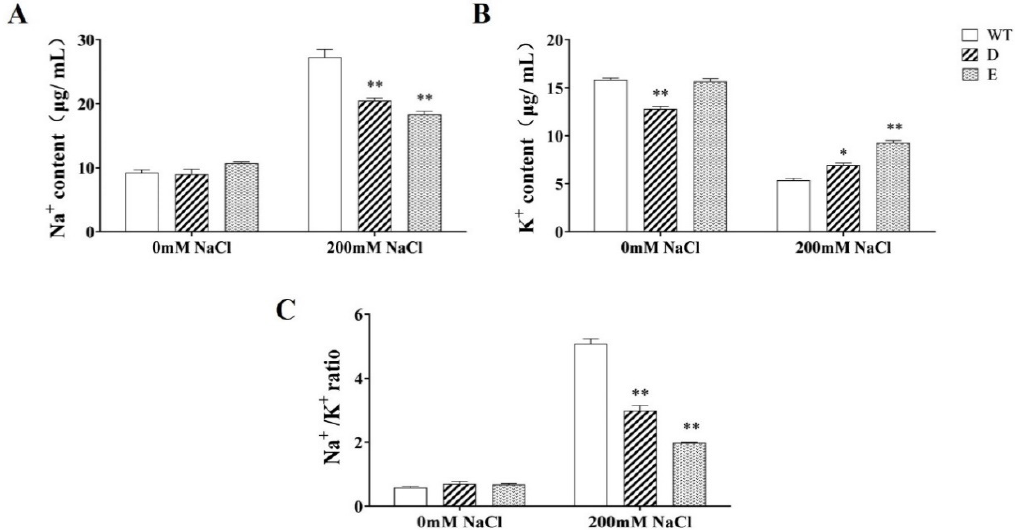
Figure 6. Changes in Na + and K + contents ( A , B ) and Na + /K + ratio ( C ) in the hairy roots of transgenic alfalfa after salt treatment for 10 days. The values are the means ± SDs of three replicates; * indicates a significant difference ( p < 0.05); ** indicates an extremely significant difference ( p < 0.01).